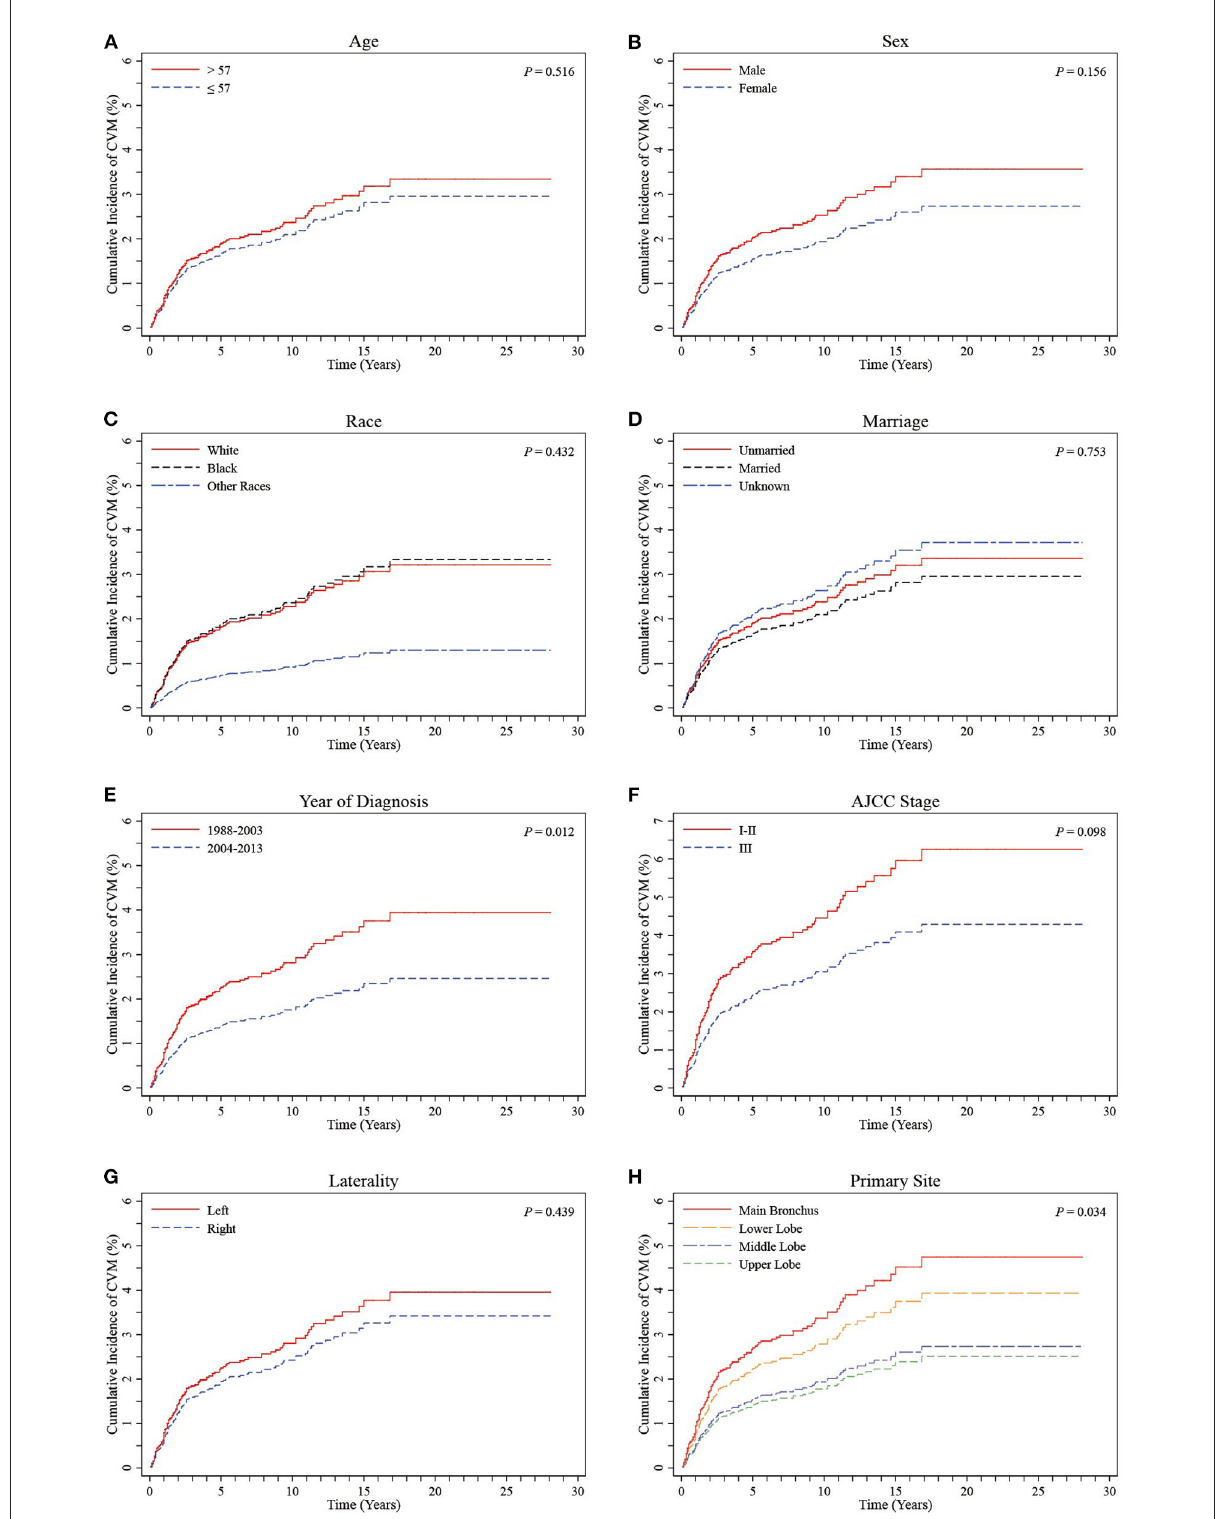
FIGURE3 CIF curves of CVM by different variables in LS-SCLC patients. (A) Age; (B) Sex; (C) Race; (D) Marriage; (E) Year of diagnosis; (F) AJCC stage; (G) Laterality; (H) Primary site (stratified into UL, ML, MB and LL groups). CIF: cumulative incidence function; CVM: cardiovascular mortality; AJCC, American Joint Committee on Cancer; LS-SCLC, limited-stage small cell lung